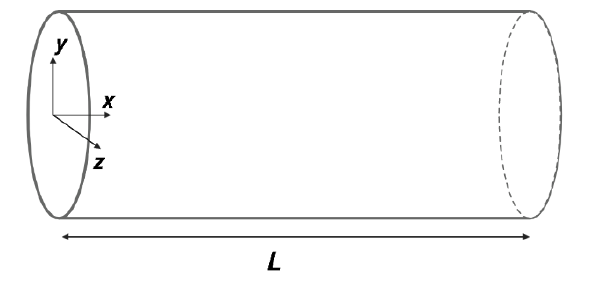
Figure 1. Schematic of a cylindrical